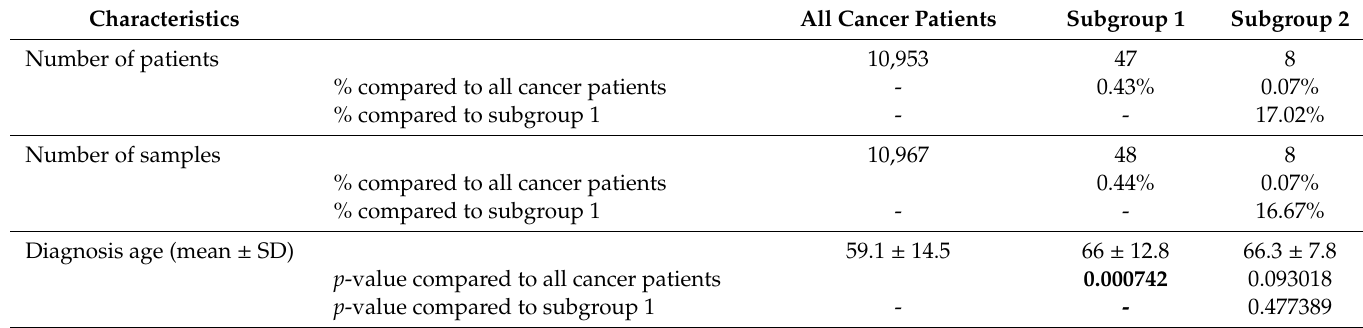
Table 3. Summary of information on the cancer patients carrying somatic mutations in the PRNP